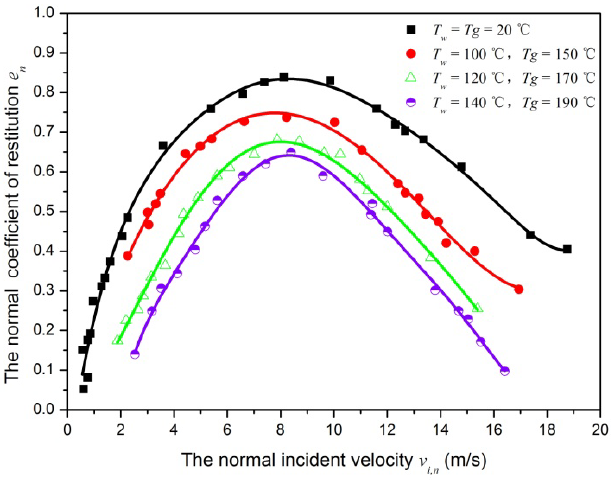
Figure 6. The normal coefficient of restitution, e under four